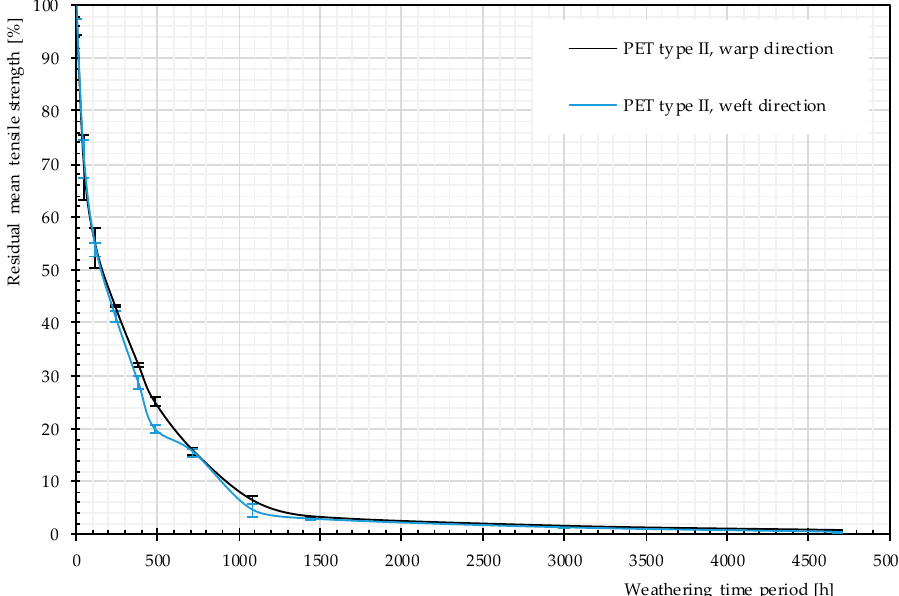
Figure 12. Residual strength, different artificial weathering durations (Method M4), PET Type II.